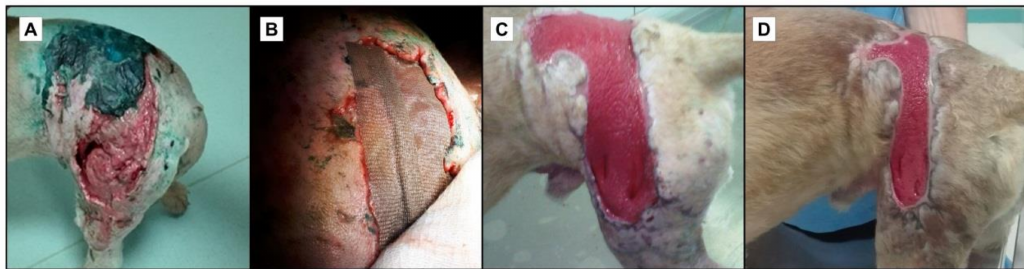
Figure 3. Clinical application of silver-containing impregnated dressing for wound healing. ( A ) Initial stage in which the wound is highly infected, a stage at which Dr. Laurentiu Leica took into consideration the possibility of skin grafting; ( B ) The use of a silver-containing impregnated polyamide dressing; ( C , D ) The beneficial effect of the dressing at 2 weeks and at one month, respectively, of follow-up. It was observed that the dressing not only exhibited antimicrobial effects but also promoted wound